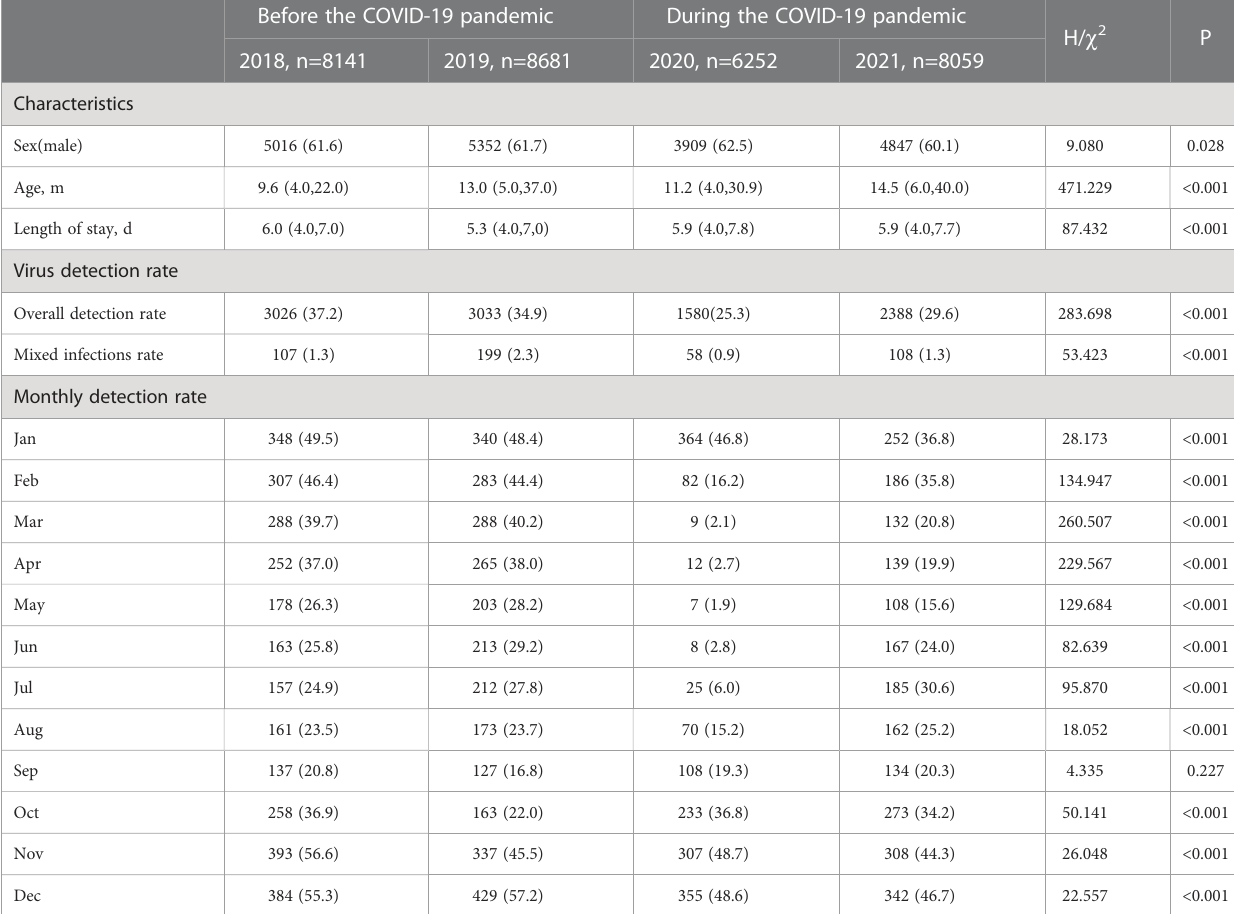
TABLE 1 Comparison of the characteristics and virus detection rate before and during the COVID-19 pandemic. Before the COVID-19 pandemic During the COVID-19